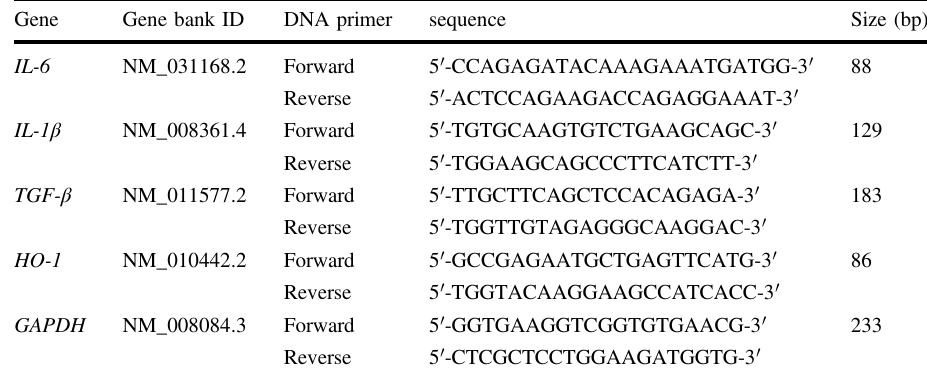
Table 2 Primers for osteogenesis-related genes